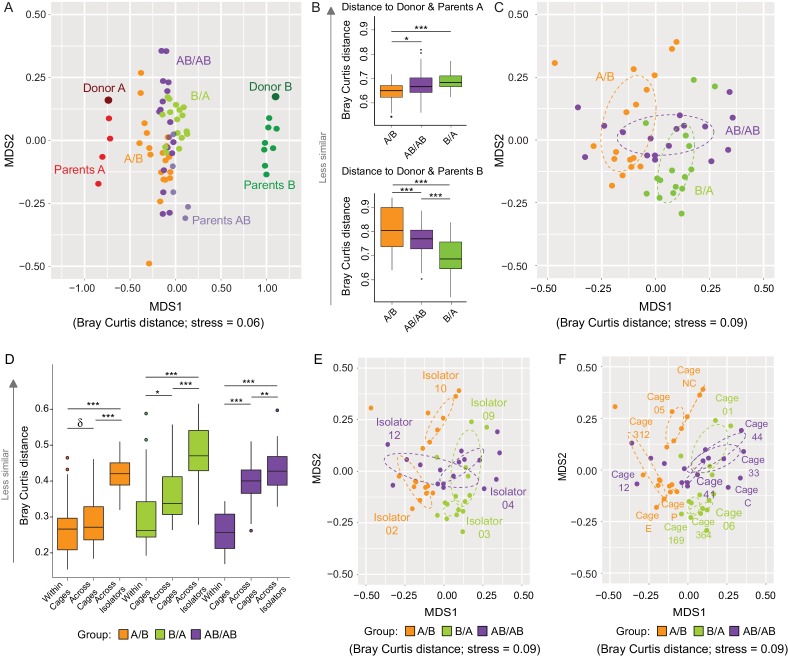
Effects of colonization order and dispersal limitations on the overall composition of the cecal microbiota.(A) Non-metric multidimensional scaling (NMDS) plots based on Bray-Curtis dissimilarities of donors A and B, parents A and B, and recipient A/B, B/A, and AB/AB mice. (B) Average Bray Curtis dissimilarities between cecal bacterial communities in recipient mice with those of the donor and parent mice. (C) NMDS plots based on Bray-Curtis dissimilarities of recipient A/B, B/A, and AB/AB mice. (D) Average Bray-Curtis distances of the cecal microbiota profile of mice housed within the same cage, across cages within an isolator, and across isolators; statistical tests were performed within treatments to exclude the effect of colonization order. (E and F) NMDS plots (Bray-Curtis dissimilarity) with samples color-coded by treatment and grouped by the isolator or cages they were housed in. Each experiment was done twice, Donor A (n = 1), Donor B (n = 1), parents A (n = 4), parents B (n = 8), parents AB (n = 6), recipient mice A/B (n = 18), B/A (n = 16), AB/AB (n = 17), isolator 02 (n = 11), isolator 03 (n = 9), isolator 04 (n = 11), isolator 09 (n = 7), isolator 10 (n = 7), isolator 12 (n = 6), cages (n = 2–5). B and D show boxplots (ggplot in R), and the data was analyzed with ANOVA; ***p<0.001, **p<0.01, *p<0.05, δp<0.1.